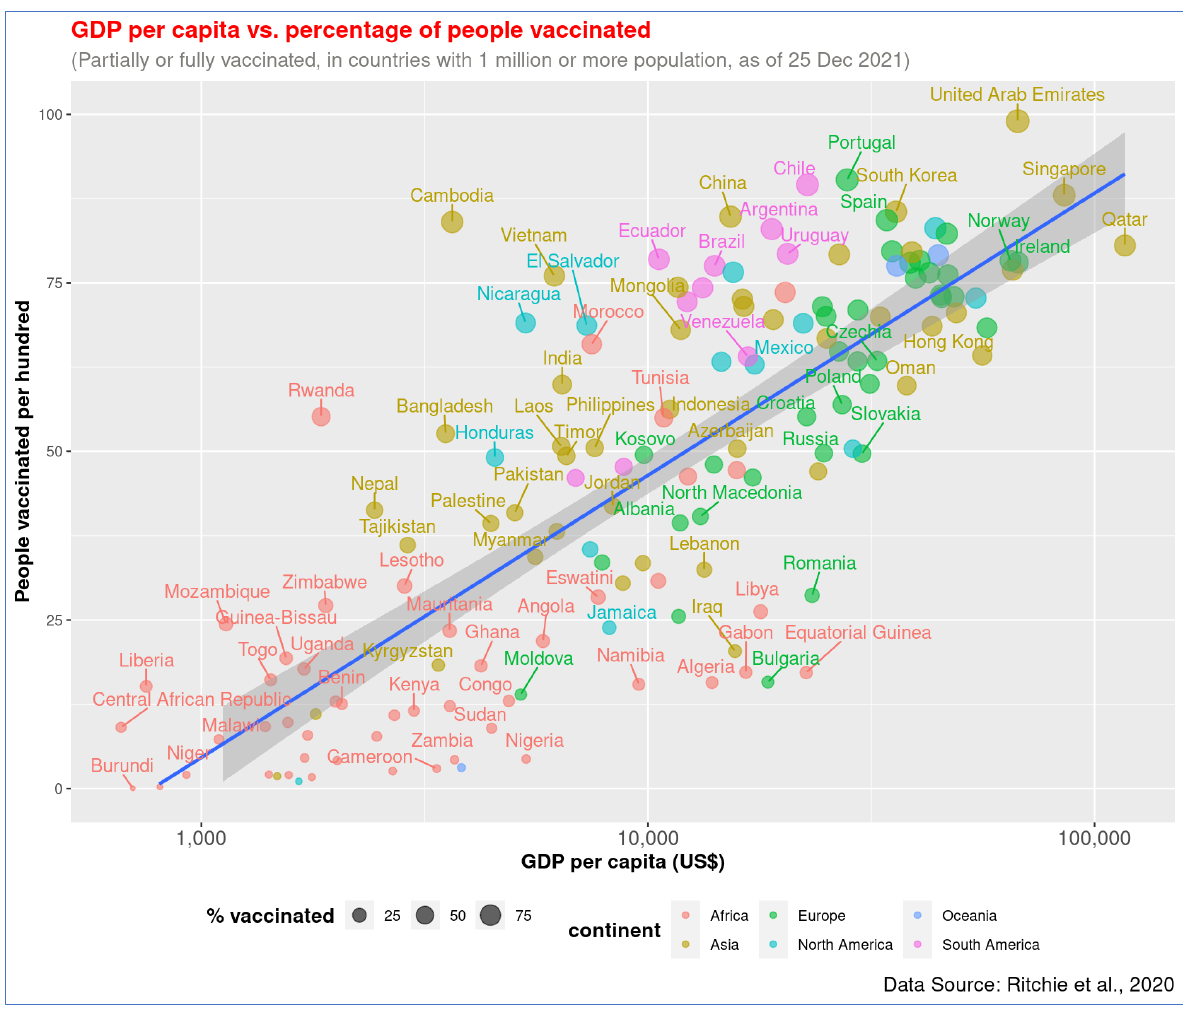
Figure 1. Association of GDP per capita and COVID-19 vaccination rate (full or partial) across countries. The regression line has been presented with blue color. The figure shows that wealthier nations have higher vaccination rates.